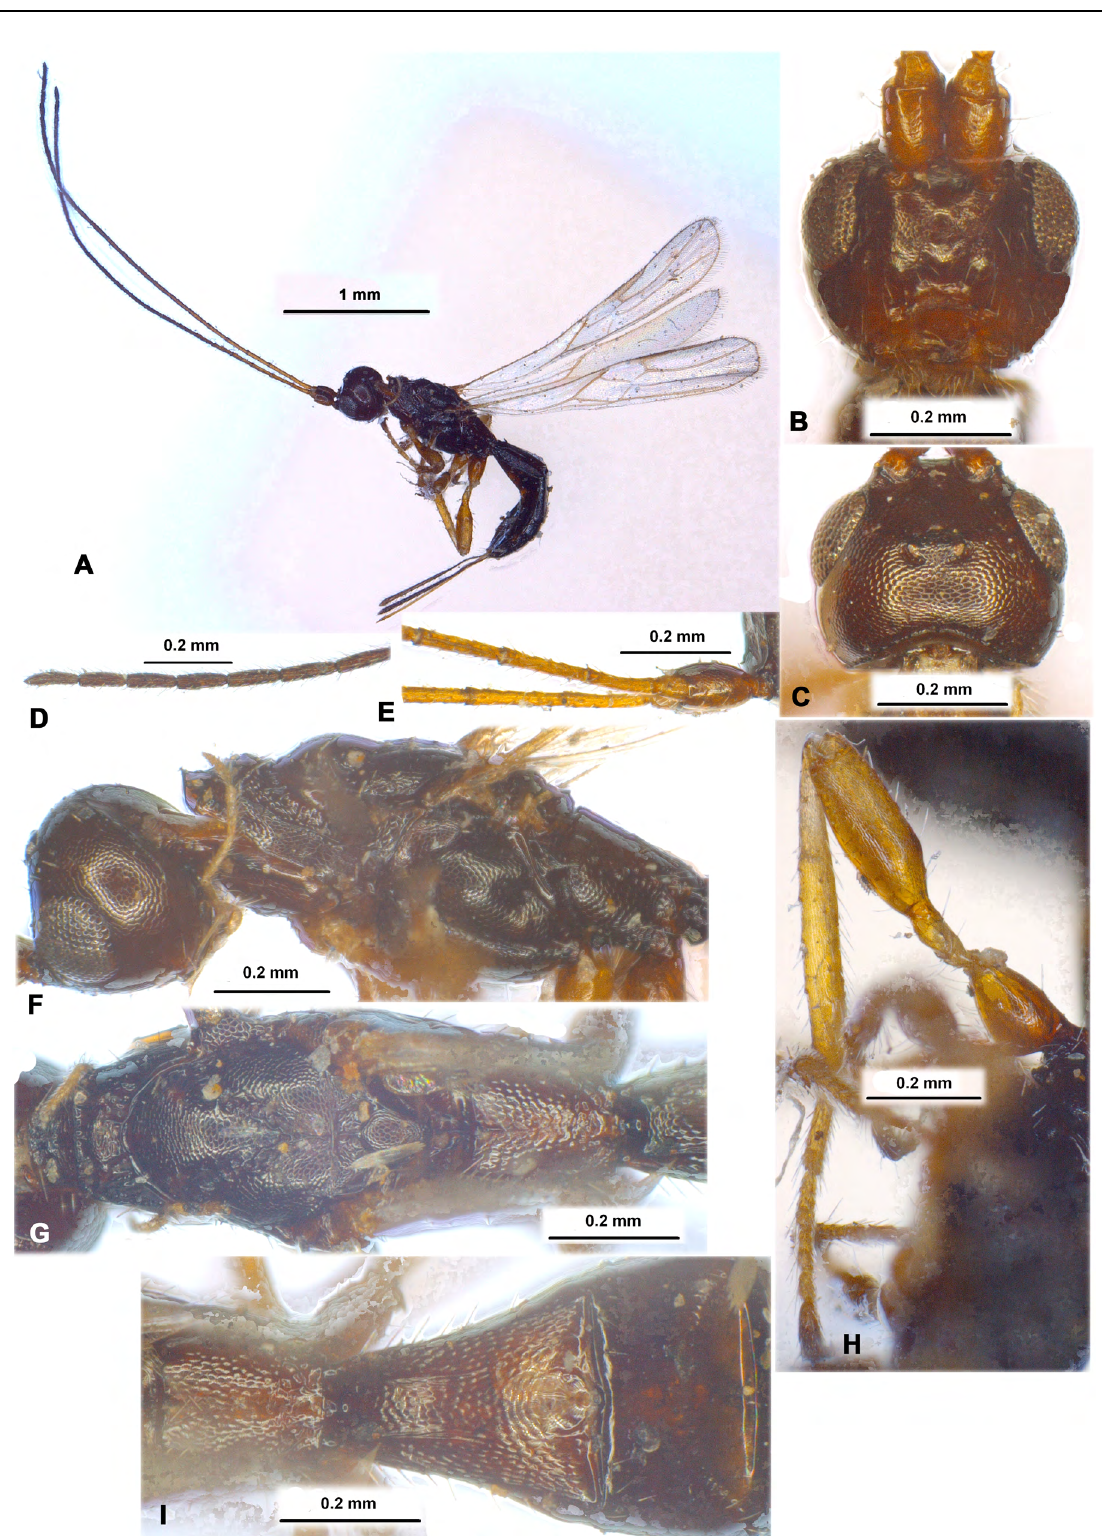
Fig. 12. Grangerdoryctes niger (Granger, 1949), ♀, holotype, MNHN. A . Habitus, lateral view. B . Head, front view. C . Head, dorsal view. D . Apical segments of antenna. E . Basal segments of antenna. F . Head and mesosoma, lateral view. G . Mesosoma, dorsal view. H . Hind leg. I . Propodeum and first to second metasomal tergites, dorsal